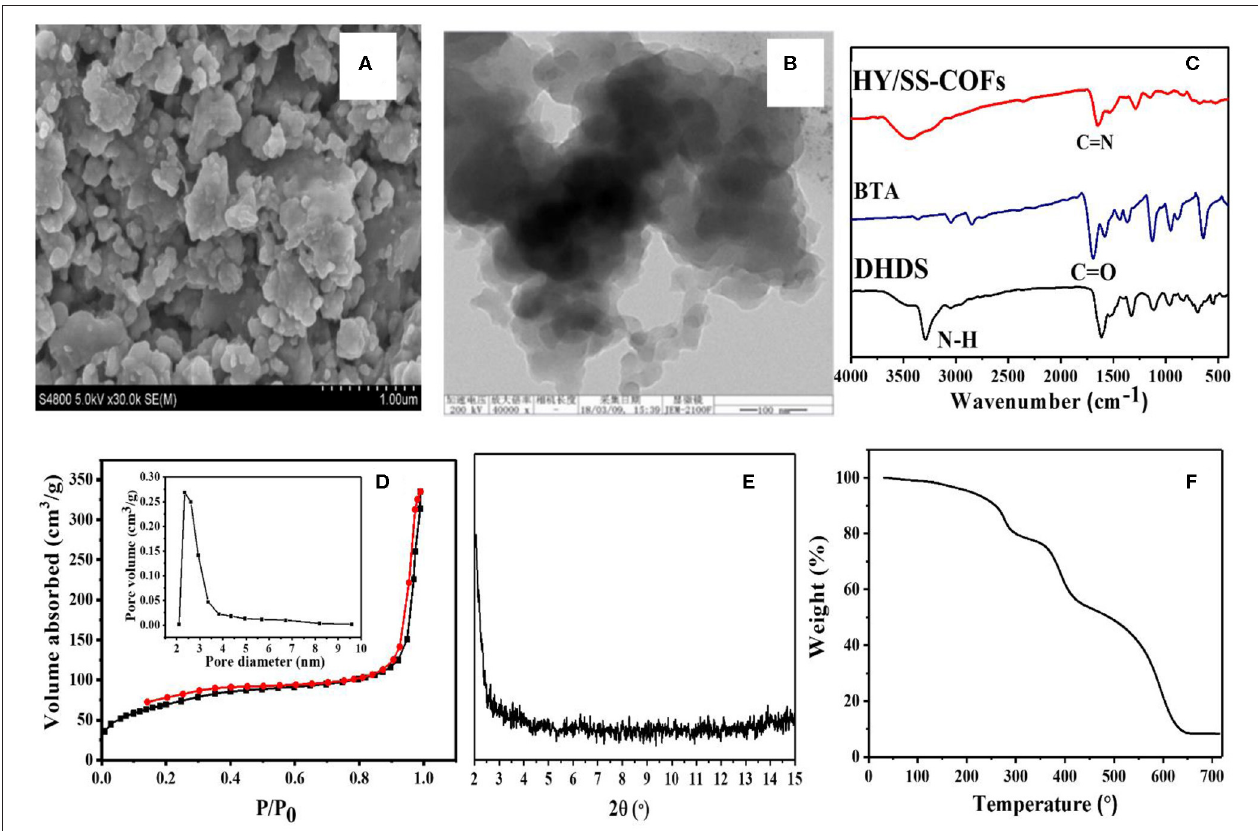
FIGURE 2 | Characterizations of HY/SS-COFs. (A) SEM image and (B) TEM image; (C) FTIR spectra of HY/SS-COFs, BTA, and DHDS; (D) Nitrogen adsorption and desorption isotherms. The inset shows pore size of HY/SS-COFs; (E) PXRD pattern; (F) TGA curve.